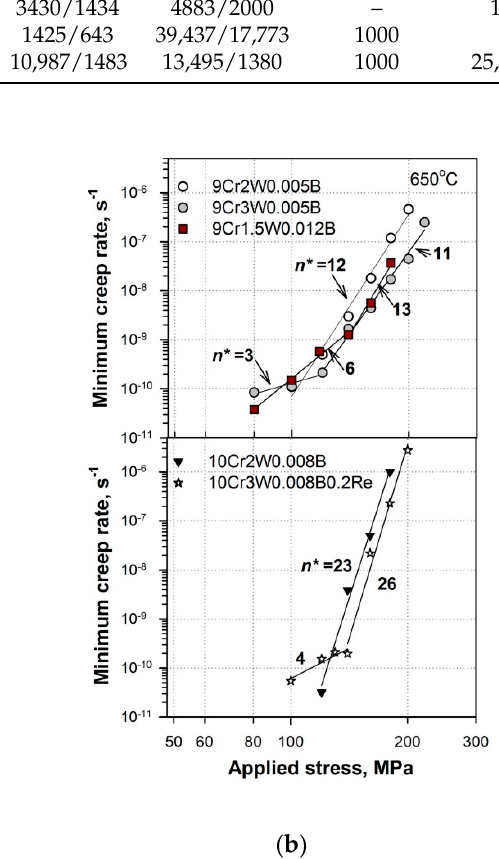
Figure 2. ( a ) Applied stress vs. time to rupture curves; ( b ) minimum creep rate vs. applied stress curves for the steels studied at 650 ◦ C under the applied stresses ranging from 80 to 200 MPa with a step of 20 MPa. Numbers in ( b ) indicate the “apparent” stress